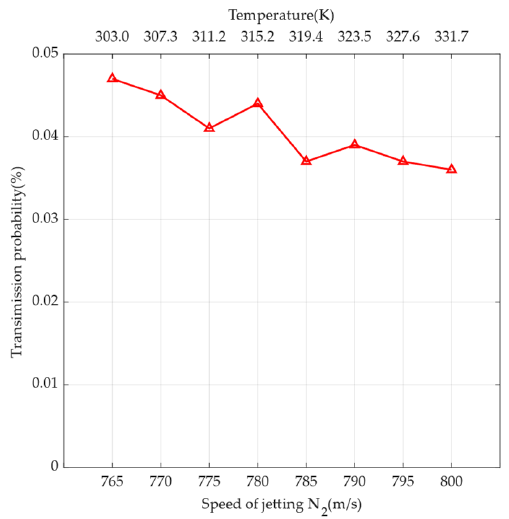
Figure 11. Relationship between speed of jetting N 2 and transmission probability. The simulation results are indicated by triangles in the line graph. The primary x-axis at the bottom indicates the speed of jetting N 2 , and the secondary x-axis at the top indicates the temperature at the corresponding speed. The y-axis indicates the transmission probability, which is the ratio of the number of particles received at the sensor sampling port to the total number of